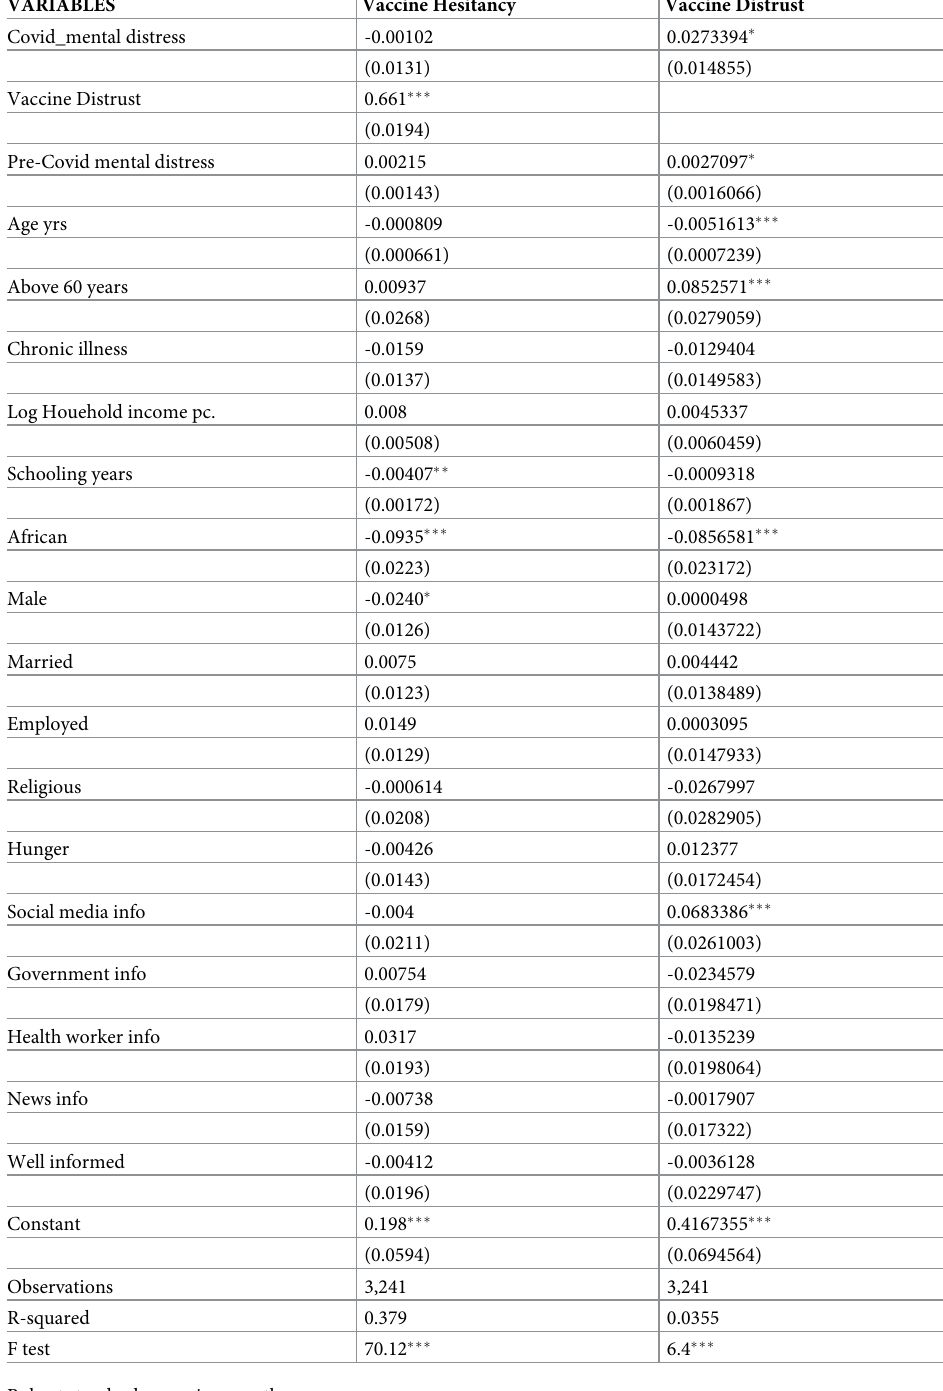
Table 3. Mediation regression